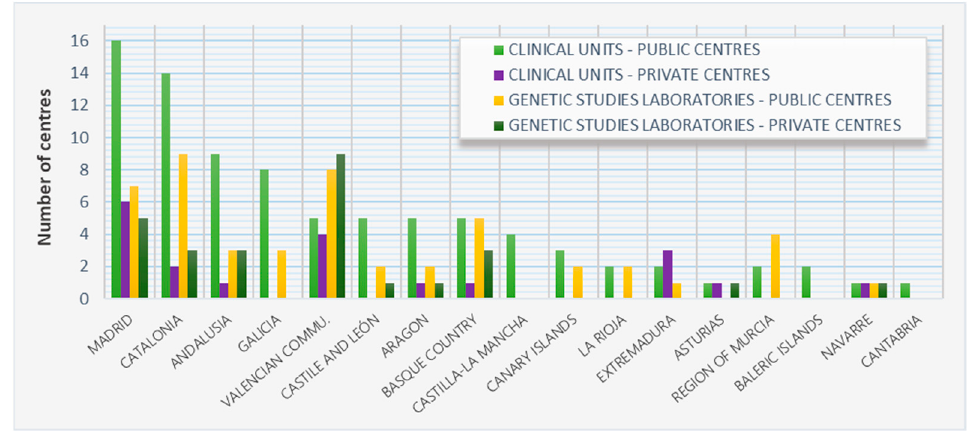
Figure 1. Number of public and private centres in Spain providing Genetic Counselling services by region. Source: Spanish Society of Medical Oncology (SEOM), 2021.